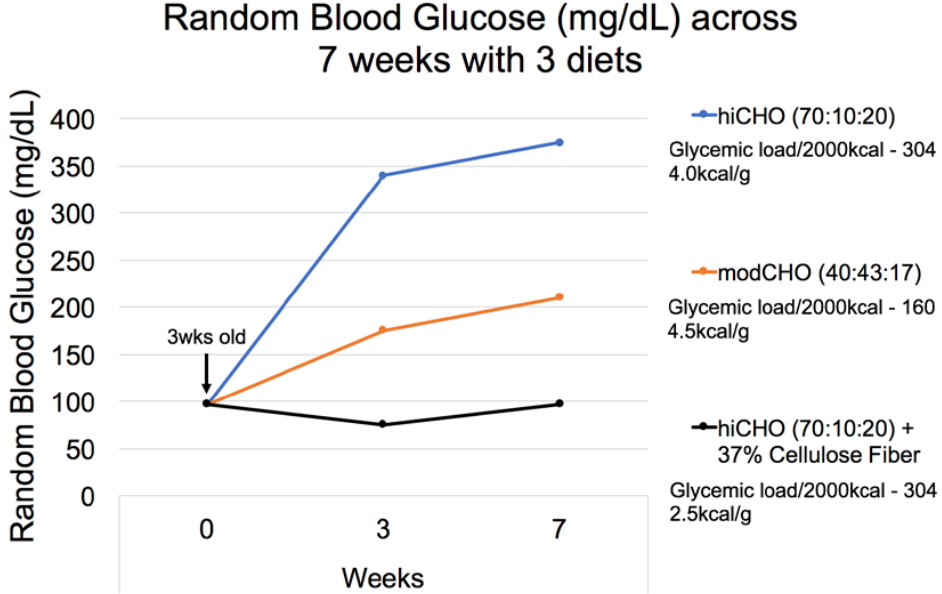
Figure 15. Seventy-eight male Nile rats were weaned at 3 weeks of age and split into three equal groups (Study 48): 1. A hiCHO diet (70:10:20 CHO:Fat:Protein %energy, 4.0 kcal/g, Glycemic load 304); 2. A modCHO diet (40:43:17, 4.5 kcal/g, Glycemic load 160); 3. A hiCHO diet + non-fermentable fiber (70:10:20, 2.5 kcal/g, Glycemic load 304), i.e., supplemented with 37% cellulose to match the low